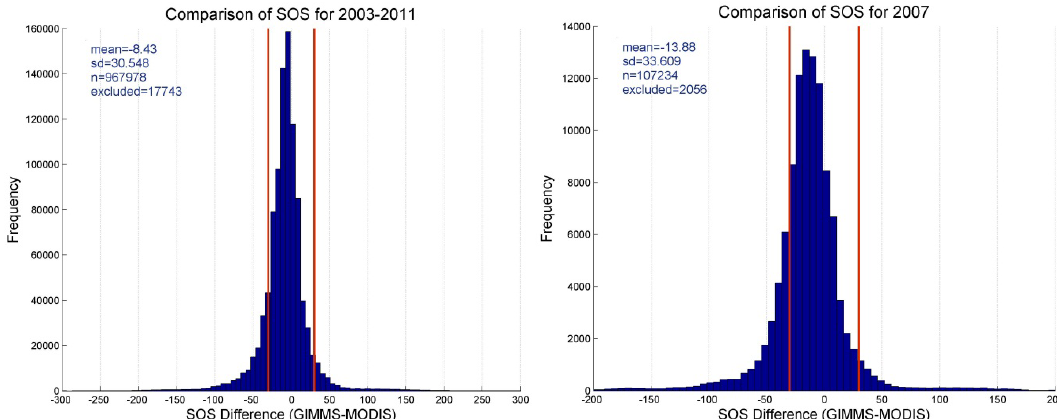
for 2007 estimated by GIMMS (top) and MODIS (bottom). The median SOS across all years (Figure 12, left) confirms again the large differences between the two data sets regarding the SOS. Figure 11. Frequency distribution of differences in the start of season (SOS) from 2003 to 2011 ( left ) and for 2007 ( right ). Differences in SOS are expressed in days.